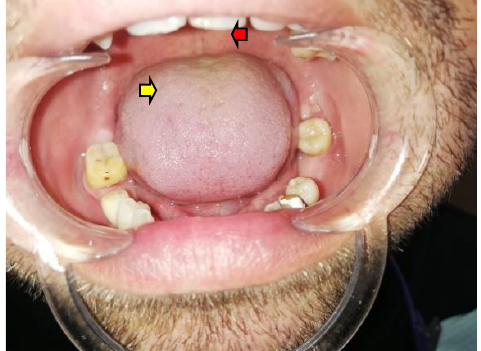
Figure 3. Addison disease with poor control of disease in an adult male: tongue anomalies revealing depapillation with fissured and brown pigmented lingual features (red arrow shows brown pig- mented lingual features; yellow arrow shows depapillation of the tongue in addition to fissured lesions). The patient was partially compliant with glucocorticoid substitution and showed poor nutritional